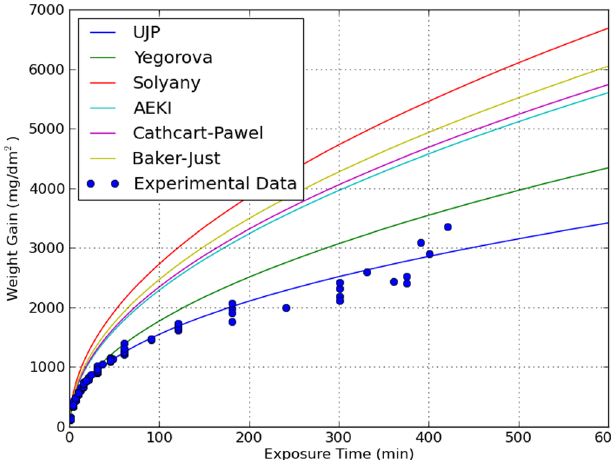
Fig. 6. Comparison of experimental data with several correla- tions, temperature 1050 ° C.